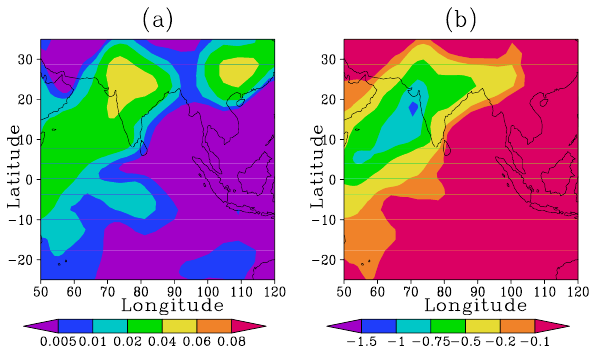
Fig. 13. Average wind field for January to March 1999 over the INDOEX domain at (a) the surface and (b) 850 hPa pressure level. western India (3 × 10 3 –4 × 10 3 particles cm − 3 ) extending to